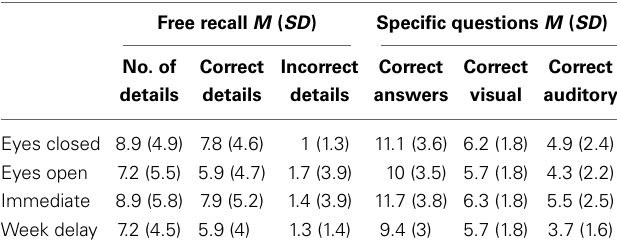
Table 1 | Mean scores for interview condition and for delay in Experiment